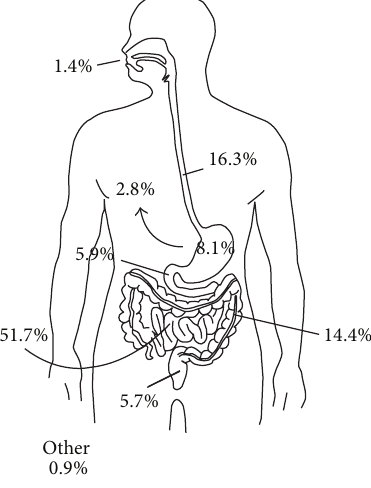
Figure 5: Alimentary tract